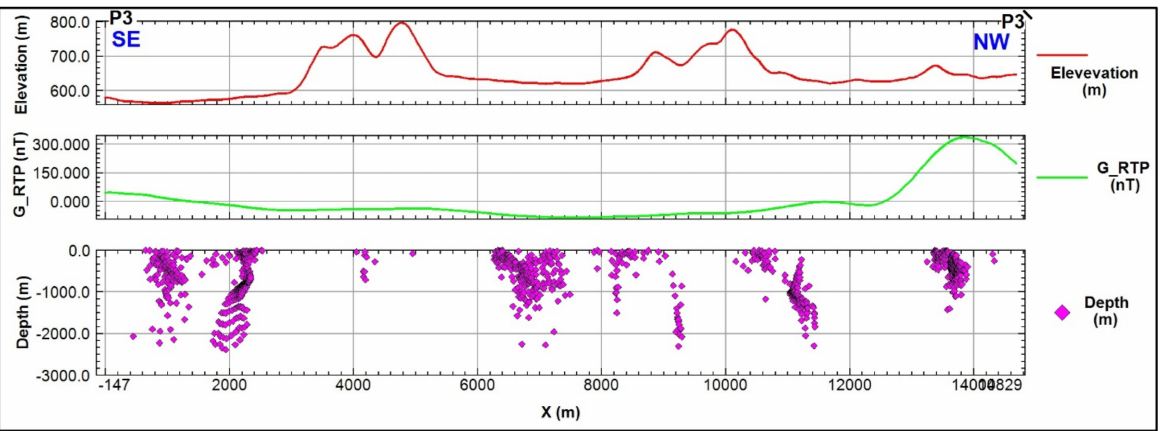
Figure 11. Analytical signal technique for aero magnetic profile (P3) of Homrit Waggat area, Central Eastern Desert,